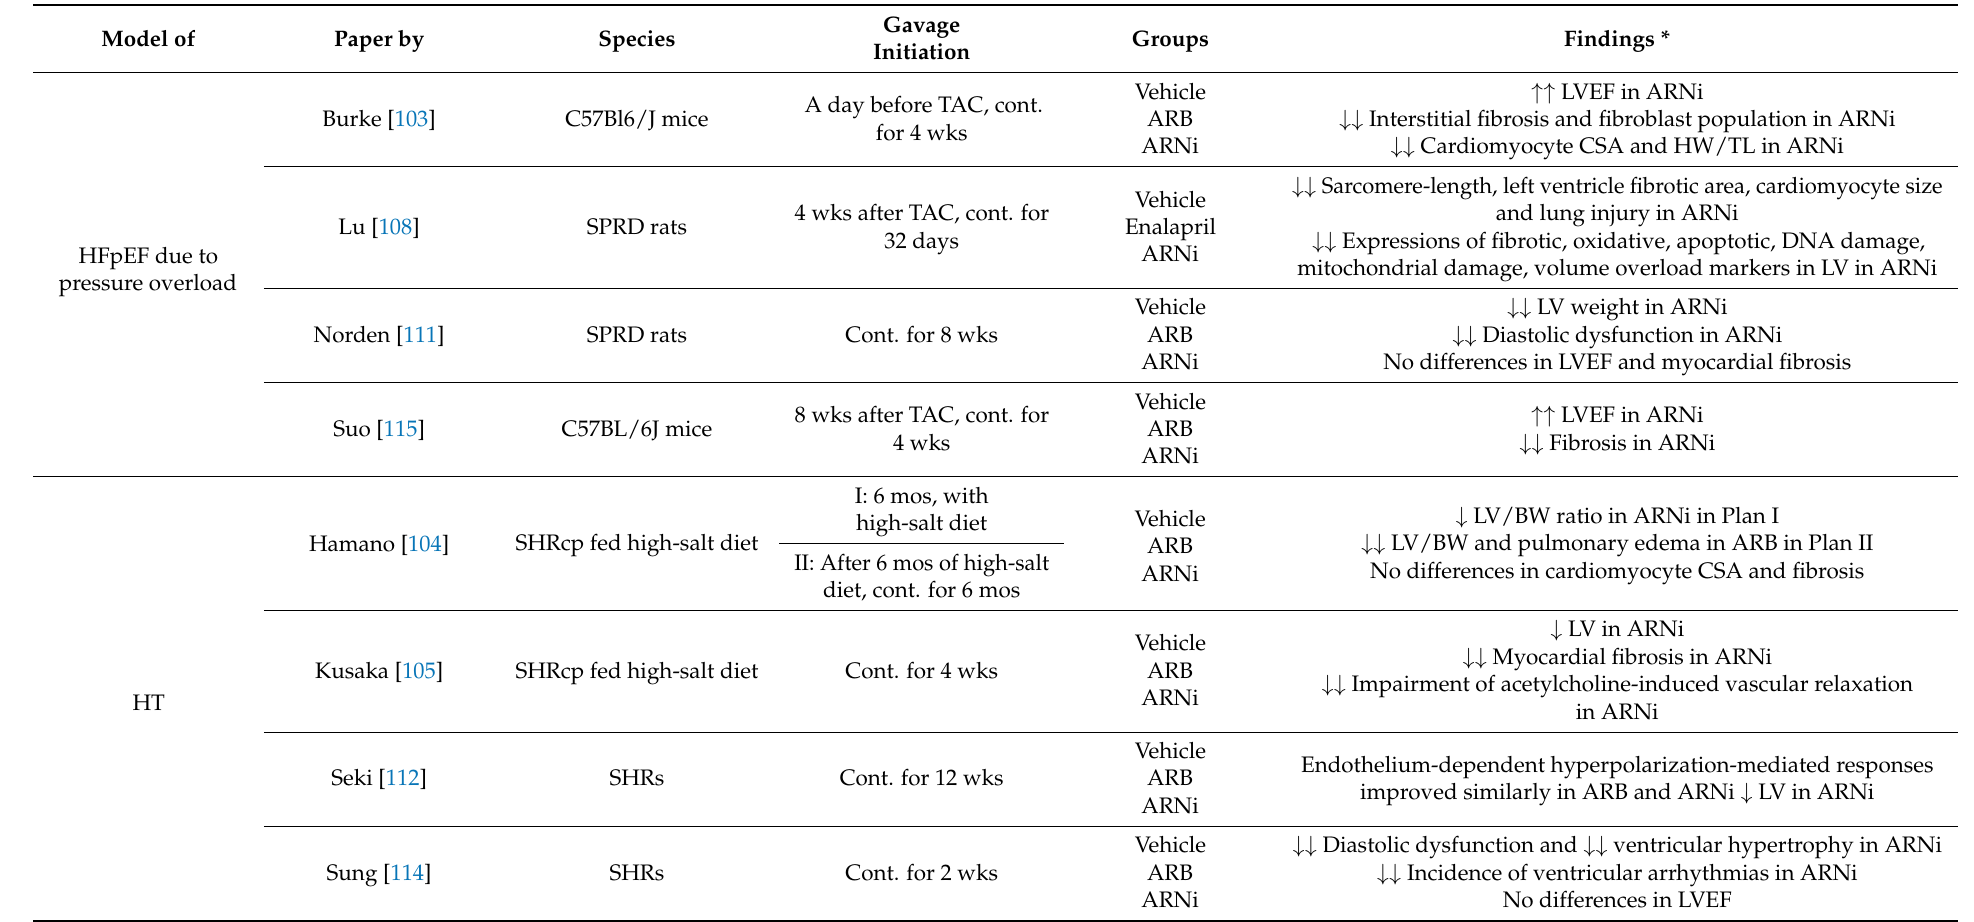
Table 2. ARNi administration compared with ARB or ACEi monotherapy in preclinical models of other cardiovascular